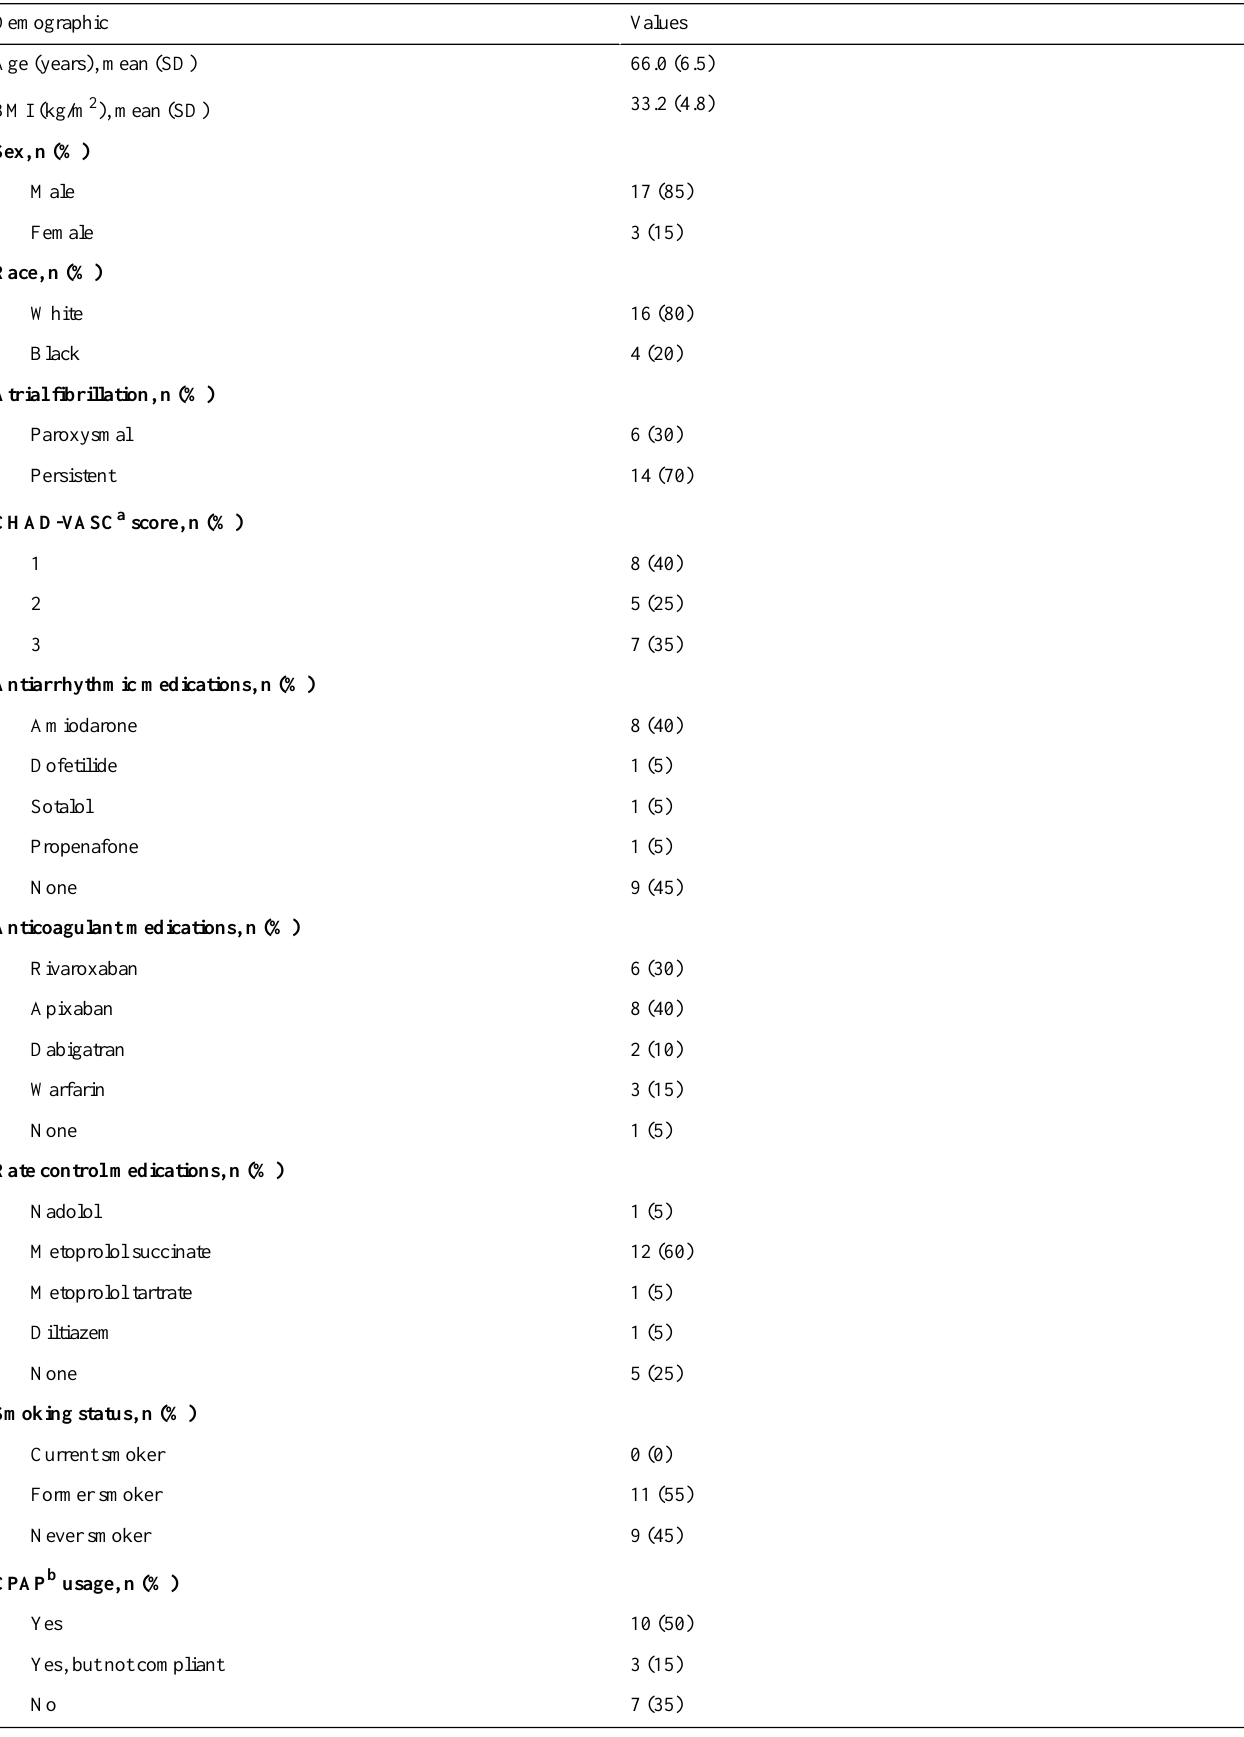
Table 1. Participant characteristics